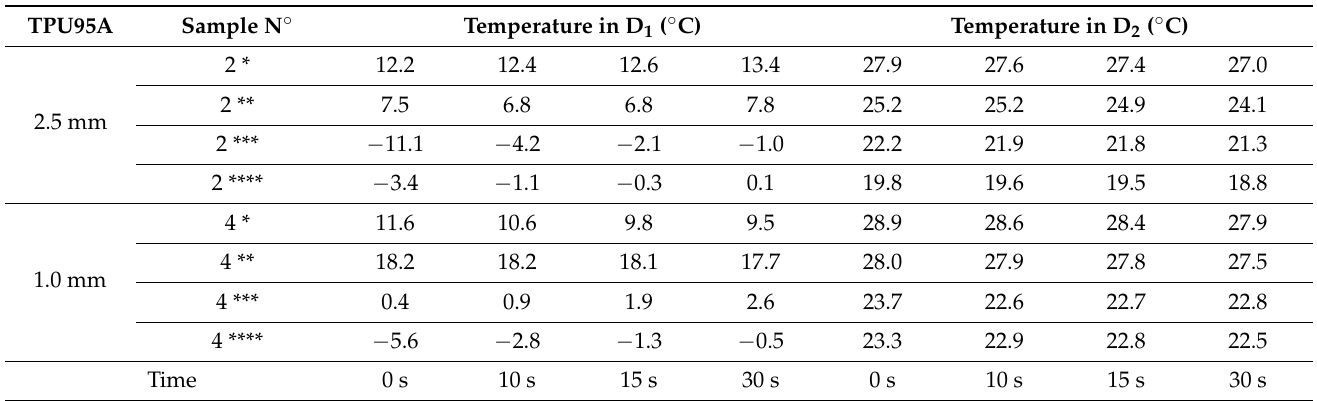
Table 4. Temperature measurements under TPU95A samples of 1.0 and 2.5 mm for the cryo-ablation procedure.